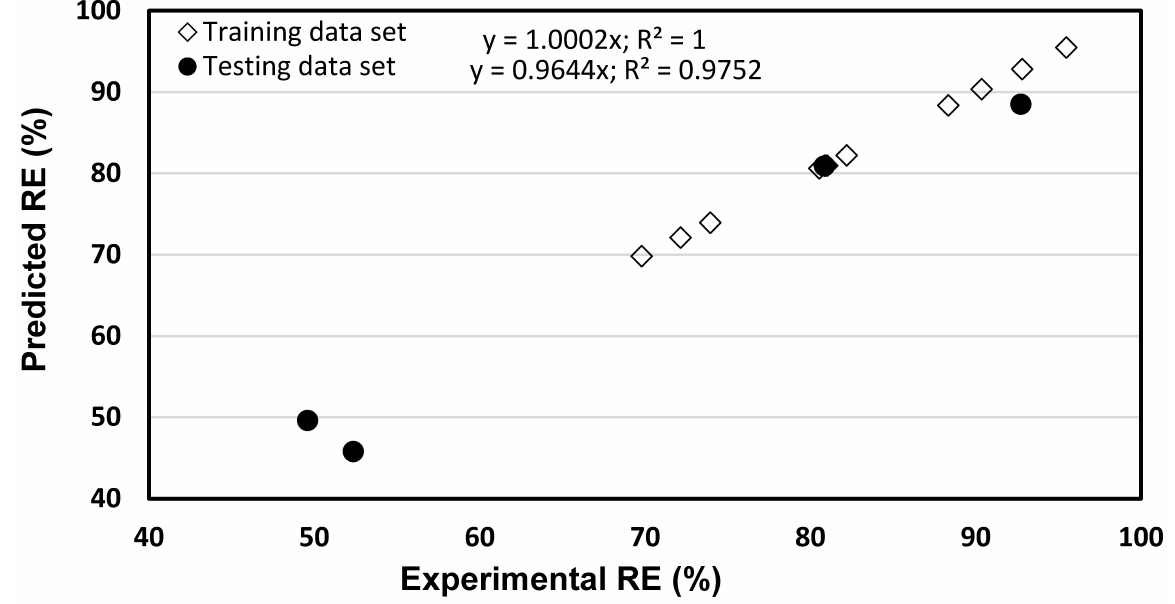
Figure 3. Experimental and predicted chromium (Cr) removal efficiencies using the ANN